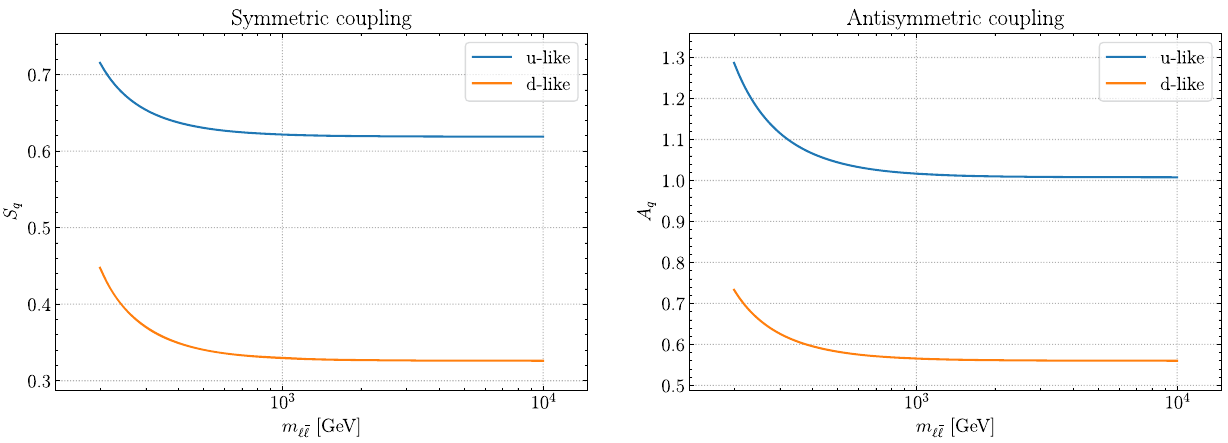
Fig. 2 The symmetric S q (left) and antisymmetric A q (right) couplings, Eq. (2.8), for up-like and down-like quarks, as a function of the dilepton invariant mass m (cid:2) ¯ (cid:2)